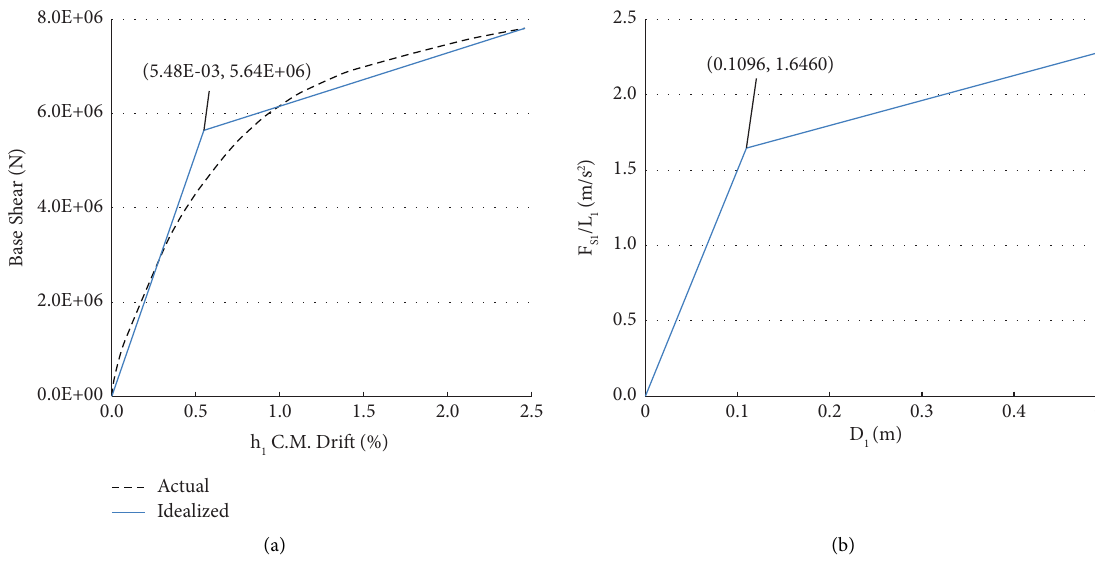
− u ) and (b) force-displacement B, 1 R, 1